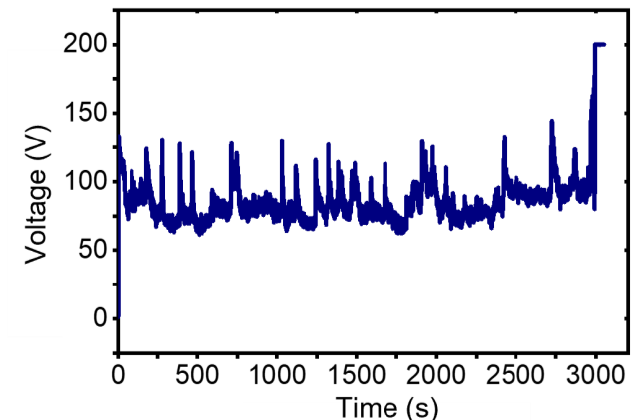
Figure 7. Working voltage versus time of a pristine MWCNT during a fatigue test.